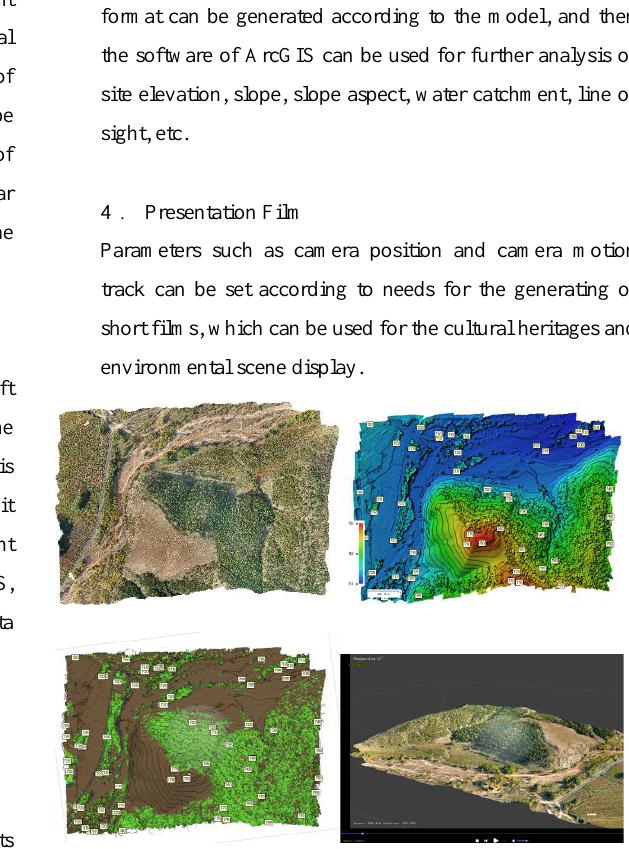
Figure 9. Orthophoto, Digital elevation model, Classification of dense point cloud, and Presentation